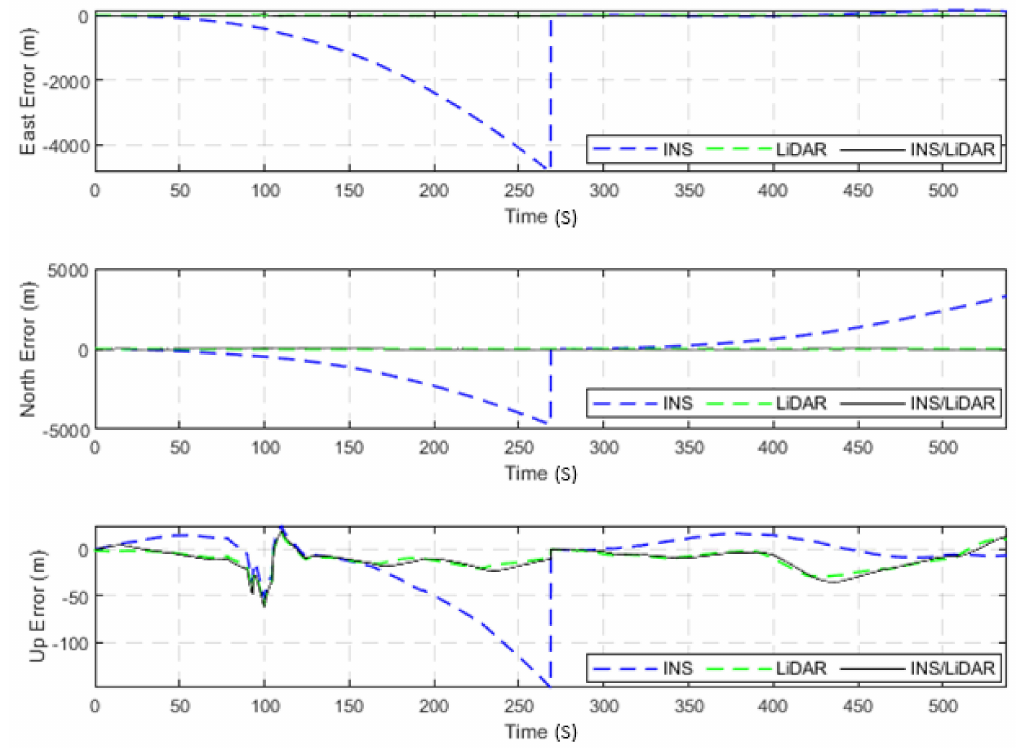
Figure 21. D-28—GNSS-assisted: position errors (ENU).